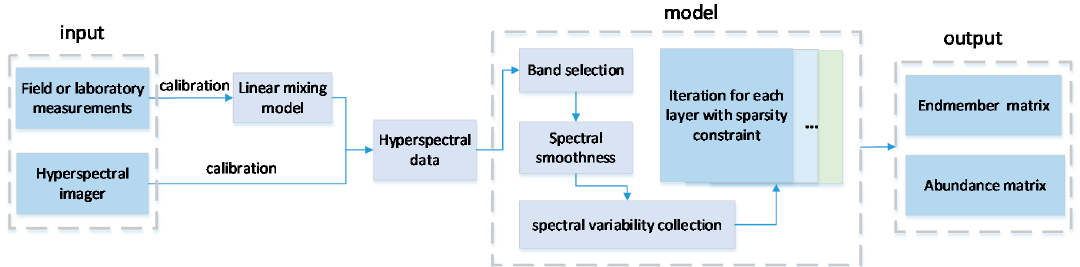
Figure 1. Schematic overview of the proposed method.